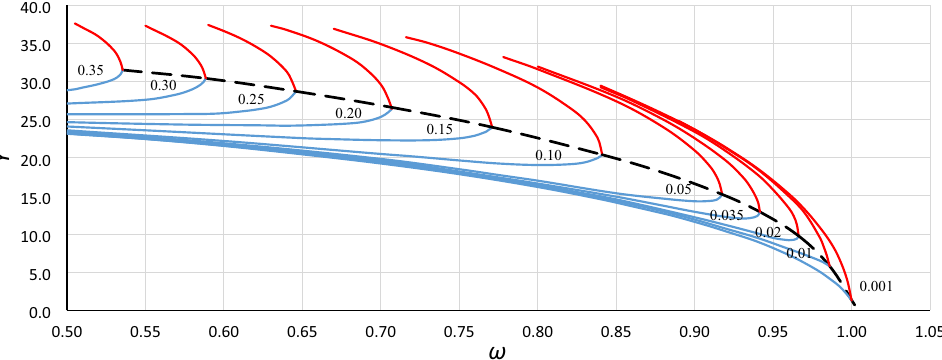
Figure 5. Curve of the origin point P B for case A2 ( α = 1.0000, β = − 0.0006, ε = − 0.0006) determined as a curve of convergence points of line L 1 (blue lines) and the upper limit of the bistability area for resonant oscillations (red lines), calculated for different values of damping coefficient η (from 0.001 to 0.35).